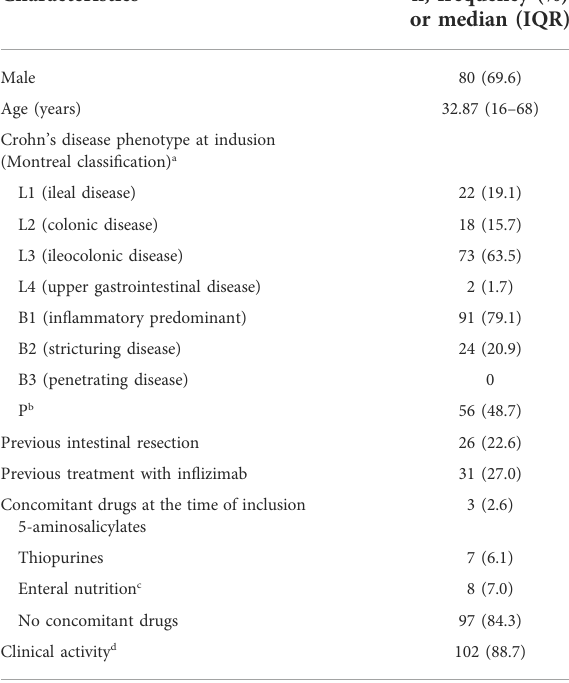
TABLE 1 Baseline characteristics of the 115 patients with Crohn ’ s disease. Characteristics